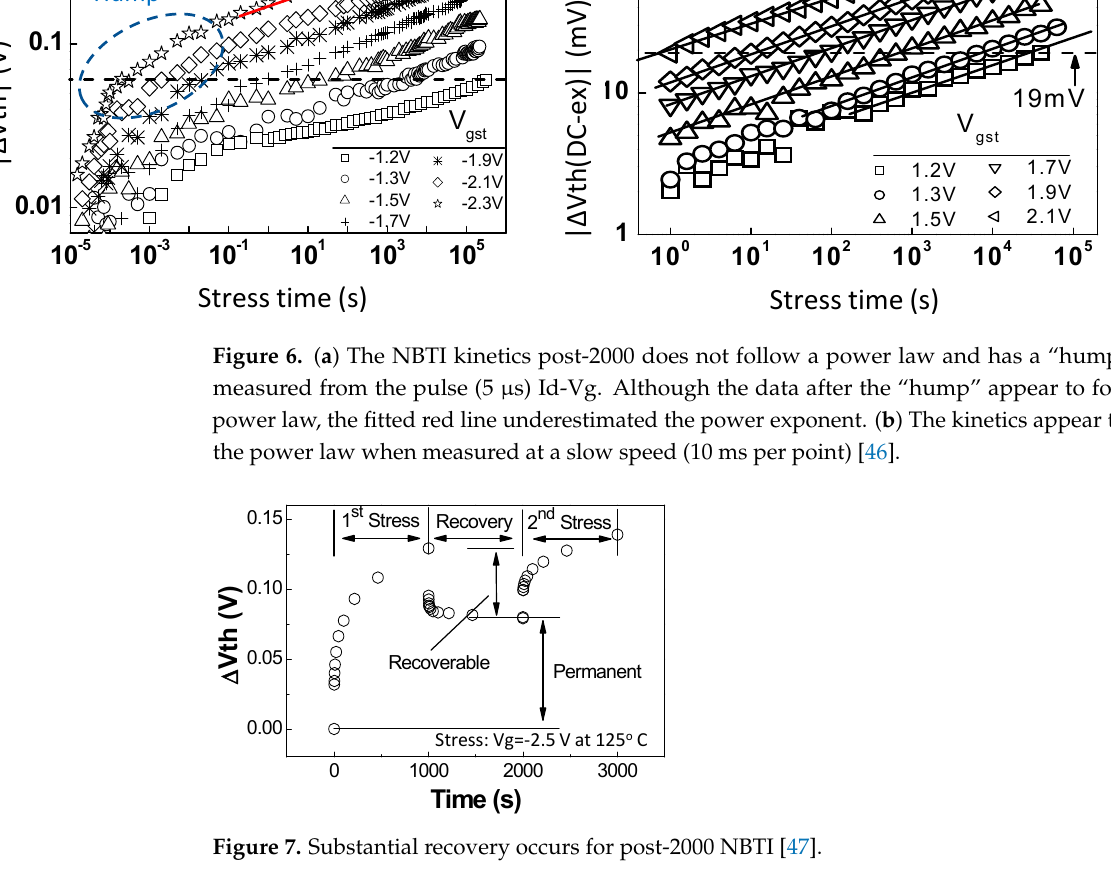
Figure 7. Substantial recovery occurs for post-2000 NBTI [47].